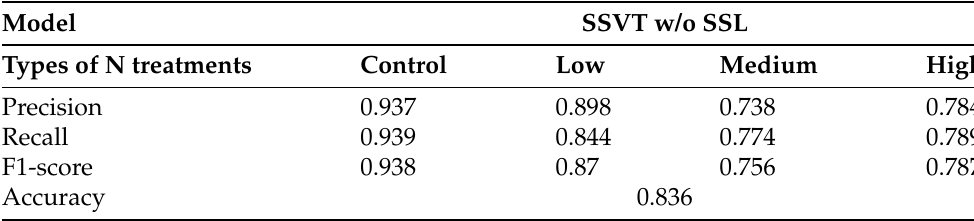
Table 6. Model performance without self-supersized learning for the four N treatments.